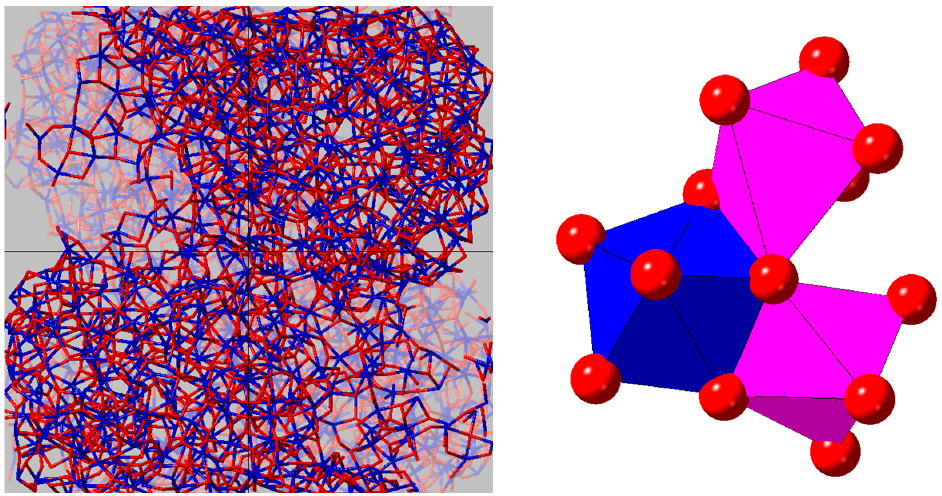
Figure 12. Snapshots taken from the MD model of amorphous hafnia nanoparticles: ( Left ) the agglomeration on nanoparticles within the simulation box; and ( Right ) edge- and corner-sharing HfO n polyhedra in the low density amorphous form.